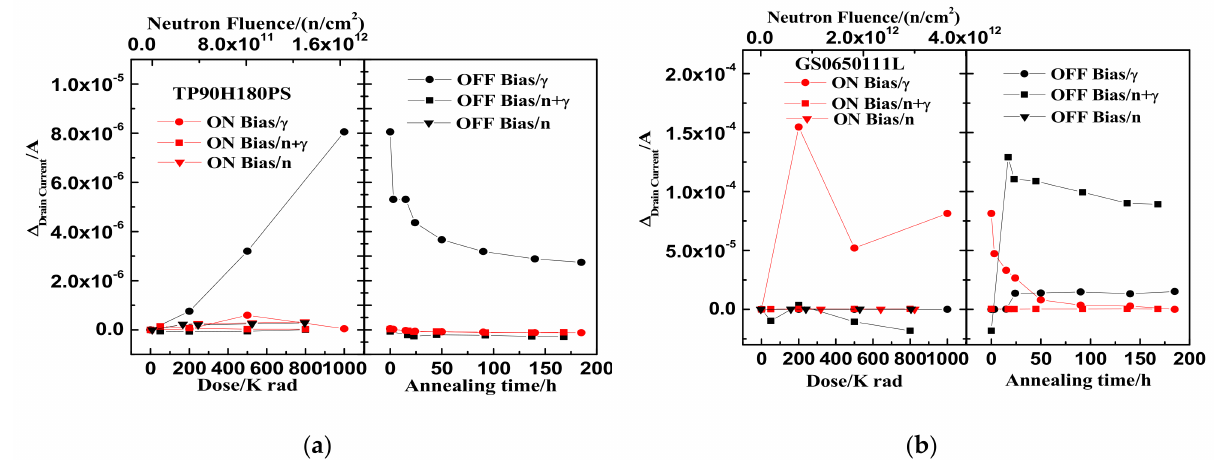
Figure 5. The variations of drain current with the neutron and gamma-ray irradiation and 168 h annealing under the on-state and off-state: ( a ) TP90H180PS and ( b ) GS0650111L.